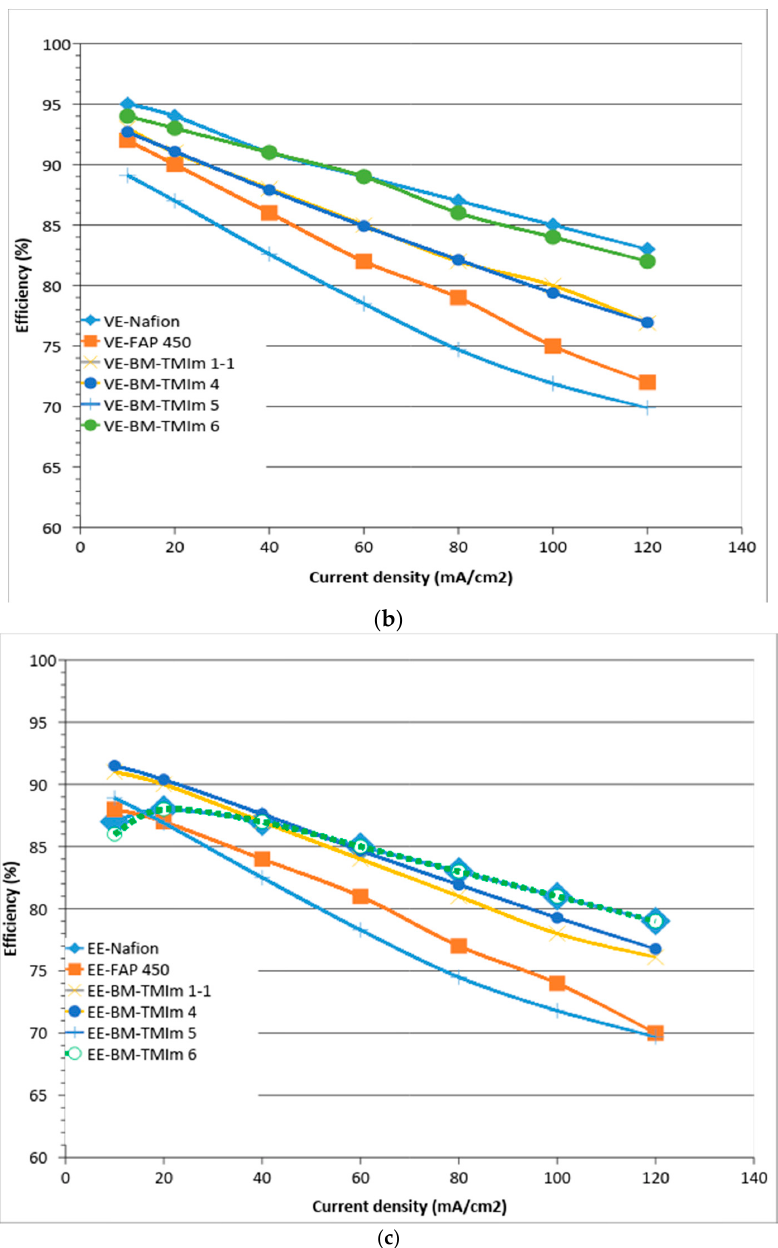
Figure 7. Coulombic efficiency (CE) ( a ); voltage efficiency (VE) ( b ); and energy efficiency (EE) ( c ) of different membranes in VRFBs at various current densities.